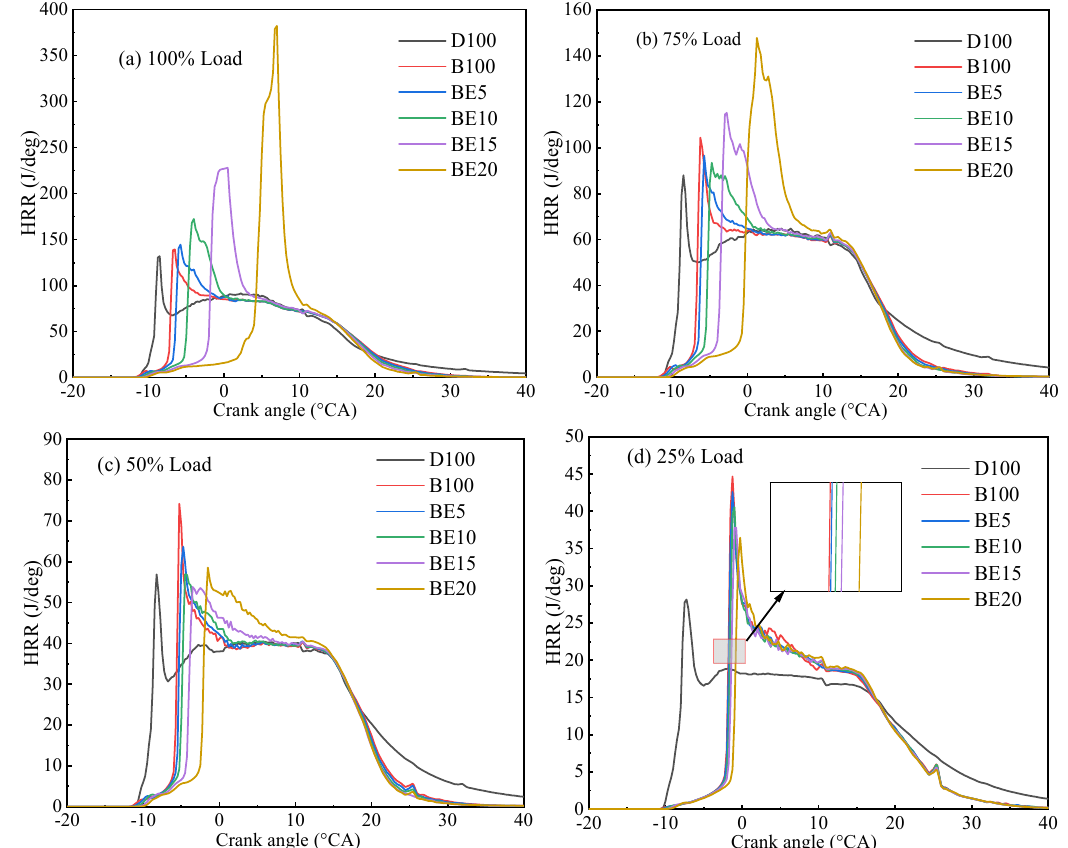
Figure 13. Comparison of HRR curves for different blends at different loads. ( a ) 100% Load, ( b ) 75% Load, ( c ) 50% Load, ( d ) 25% Load.